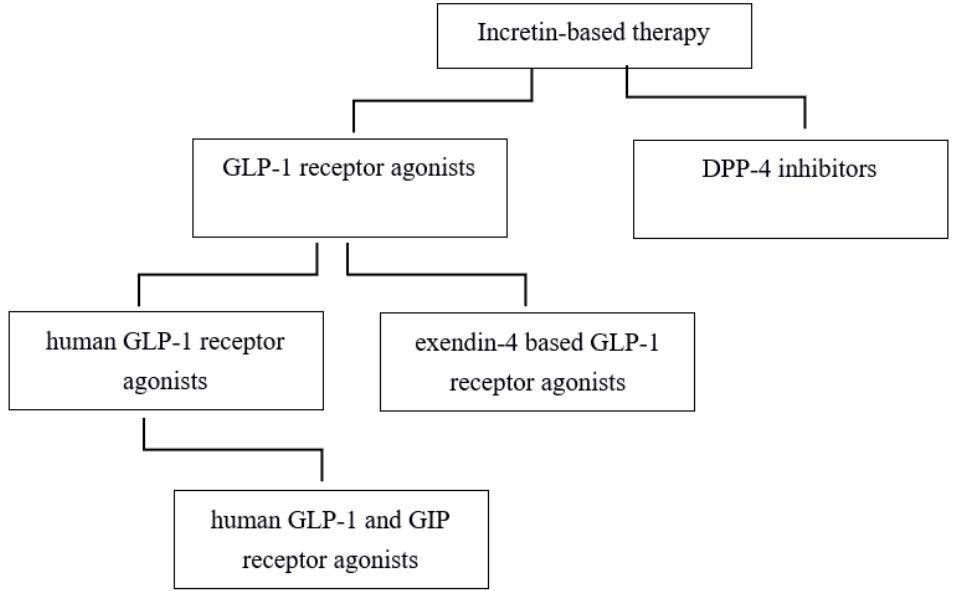
Figure 1. Incretin-based